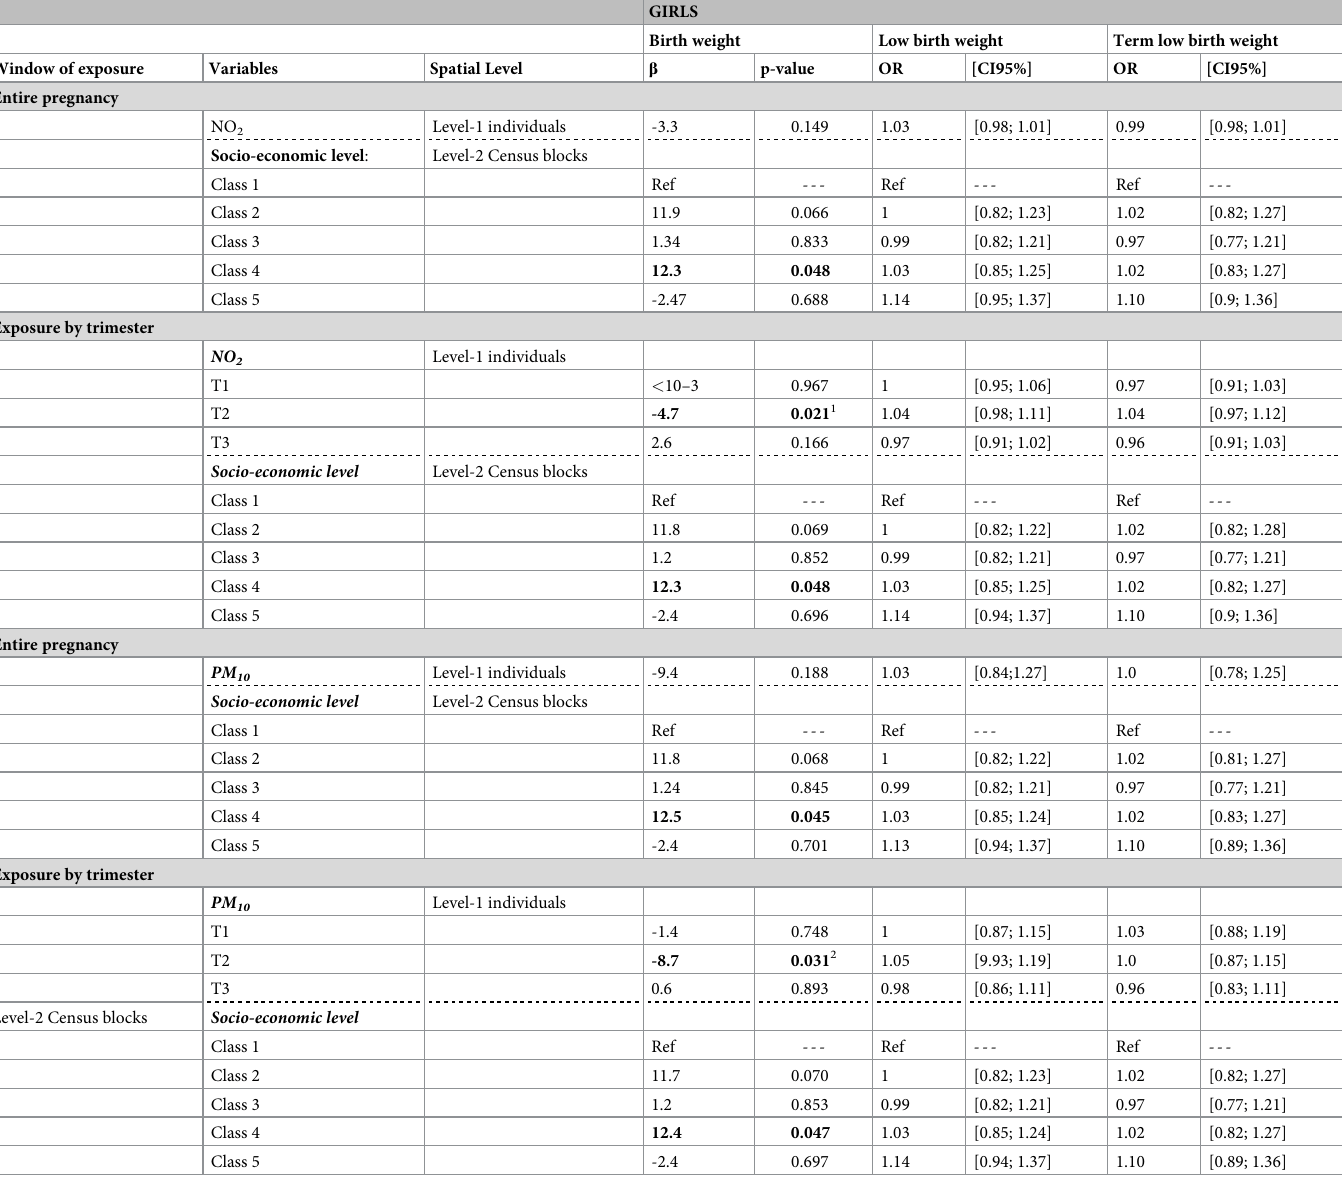
Table 6. Association between adverse birth outcome (BW, LBW, TLBW) and air pollution exposure during pregnancy plus neighborhood socioeconomic level for girls using multilevel model (defined as Model 2 in §Material and methods). GIRLS Birth weight Low birth weight Term low birth weight Window of exposure Variables Spatial Level β p-value OR [CI95%] OR [CI95%]